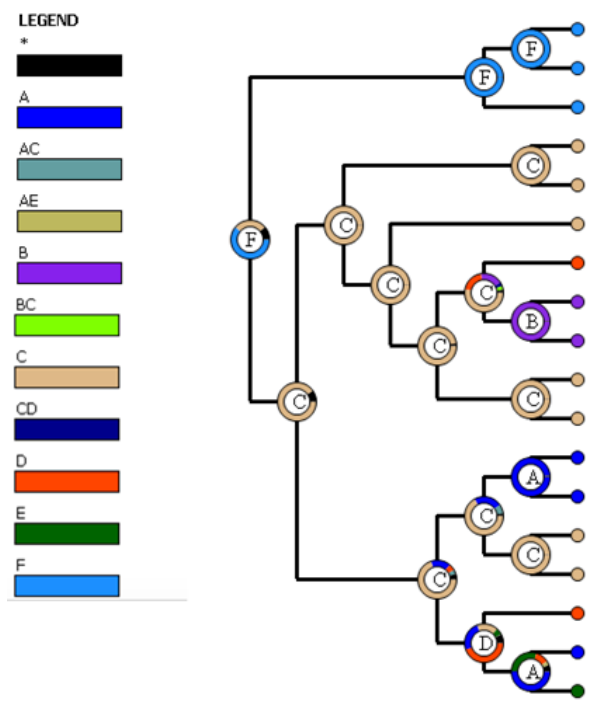
Fig 7. Cp-DNA RASP analysis based on BEAST tree (MCMC) showing probable ancestral area distribution for Ziziphora clinopo- dioides provinces. Razavi Khorasan, B- Ardebil, C- Mazandaran, D- Qazvin, E- Tehran and F- Lellemanthia